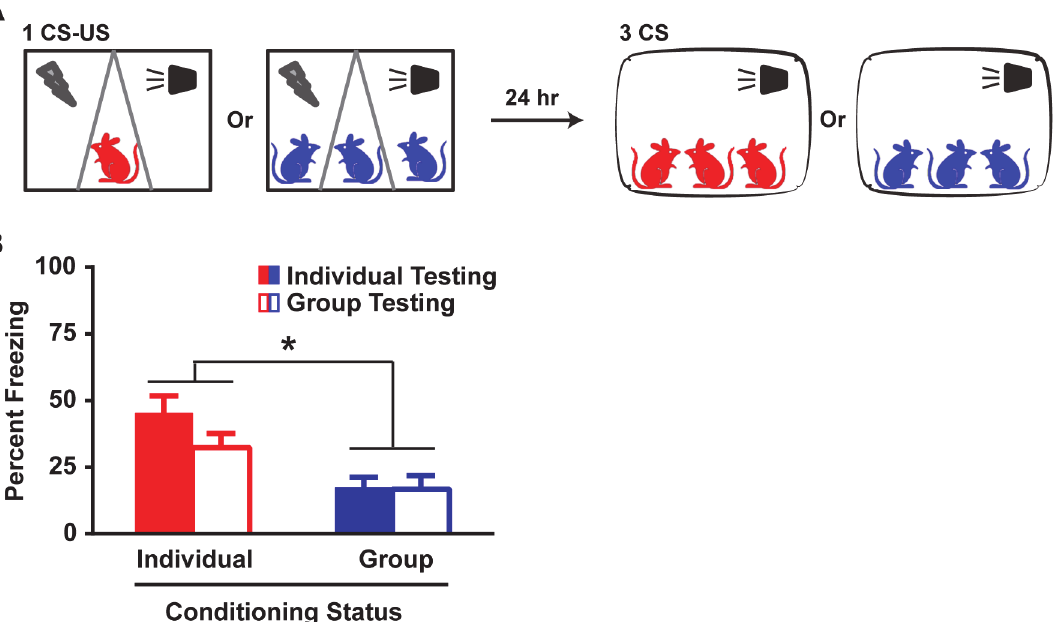
Fig 3. Group-induced fear reduction is dependent on the co-presence of cagemates during conditioning but not testing. (A) Schematic for group testing. Individual and Group rats are fear-conditioned with 1 CS-US pair as described. Twenty-four hours later, the rats are exposed to a LTM test in group with their cagemates and their freezing scores are determined manually. (B) Individual and Group rats maintained respective similar levels of freezing during a LTM test whether they were tested individually or in group. Two-way ANOVA revealed an effect of conditioning (Individual or Group), F (1, 68) = 16.89, p < 0.001, but not testing (individually or in group), F (1, 68) = 1.63, p > 0.1, or an interaction (conditioning x testing), F (1, 68) = 1.34, p > 0.1. Data presented as mean + sem.